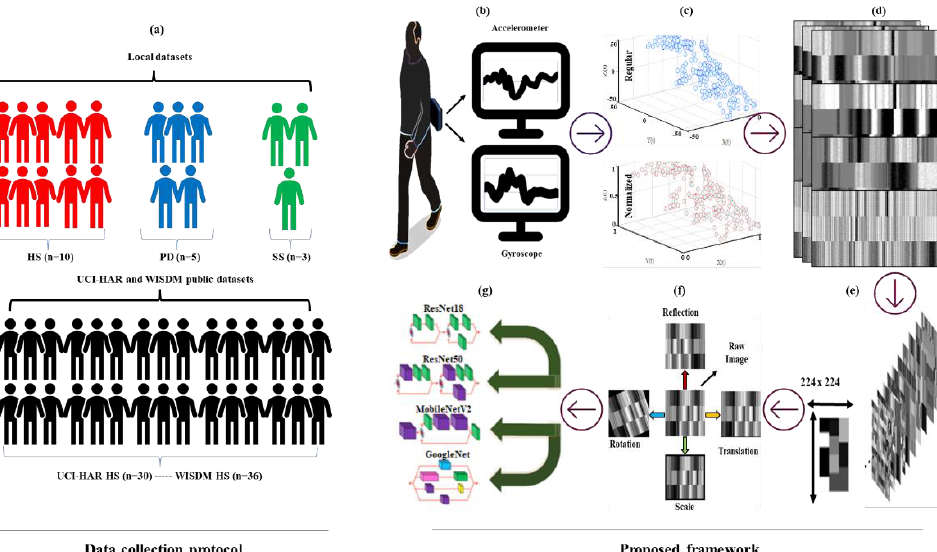
Figure 1. Data collection protocol and proposed framework: ( a ) Dataset illustration. The flow of the proposed HAR methodology with data augmentation and CNN architectures: ( b ) IMU data acquisition, ( c ) data normalization, ( d ) numerical to image conversion, ( e ) resizing, ( f ) data augmentation, ( g ) CNN classification.